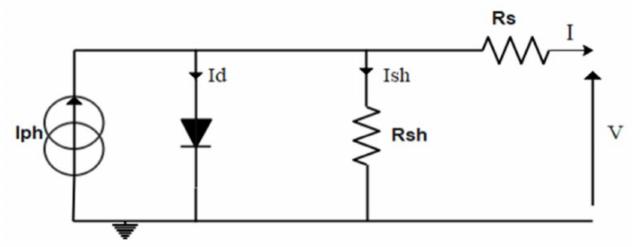
Figure 2. Photovoltaic cell circuit.